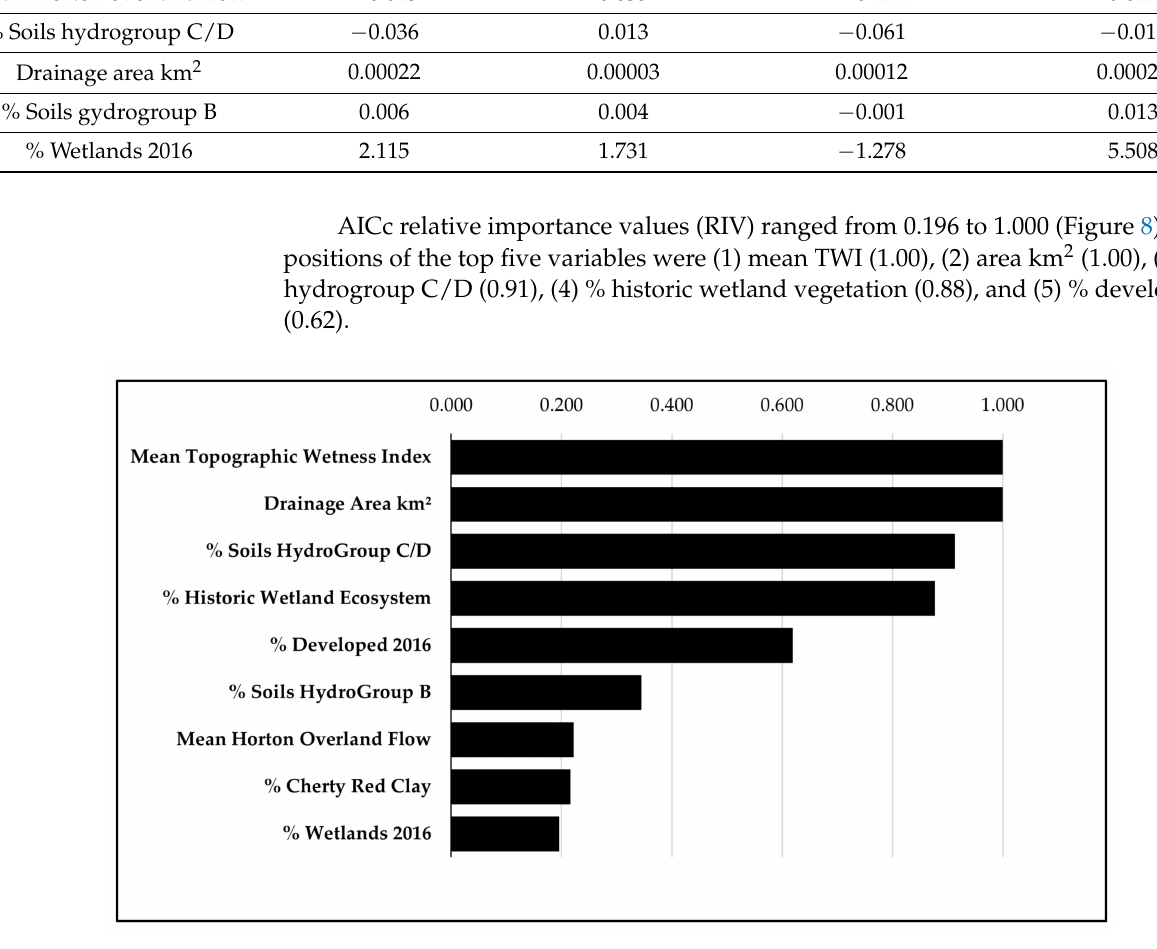
Figure 8. AICc Relative Importance Values (RIV) for nine variables included in the global model. Relative positions of variables shifted when subjected to hierarchical partitioning. The relative positions of the top five highest scoring variables were (1) mean TWI (32.9%), (2) area km 2 (22.0%), (3) % cherty red clay (12.8%), (4) % Soils hydrogroup CD (9.5%), and % Soils hydrogroup B (7.9%) (Figure 9). Percent cherty red clay was not included in any of the top six AIC models but ranked in the top three by hierarchical partitioning. Percent soils hydrogroup B moved above % historic wetland ecoregion. The other three variables in aggregate accounted for less than 10%